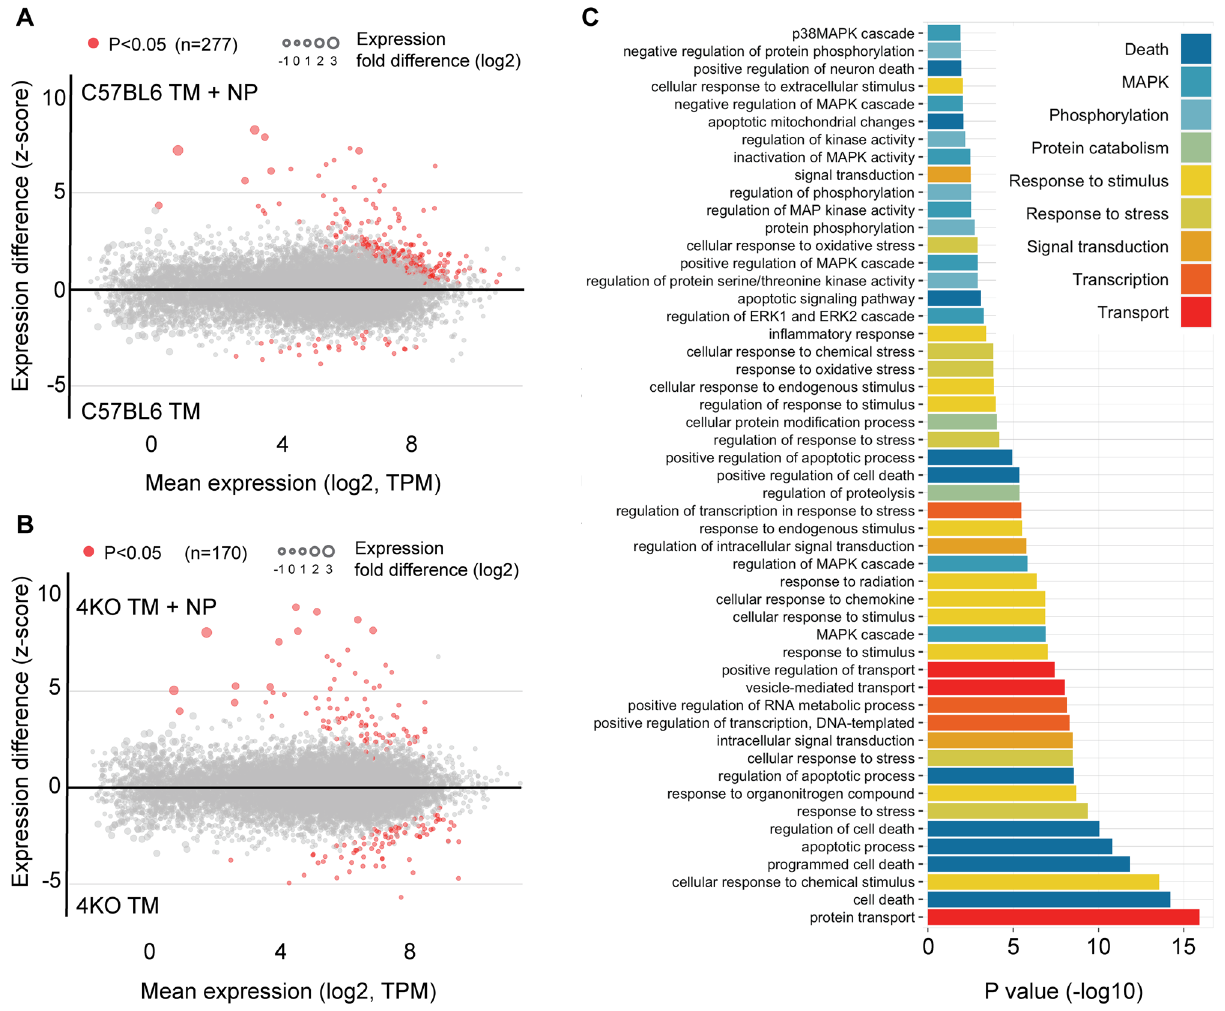
Figure 3. Synthetic nanoparticles trigger activation of MAPK signaling in TM-preconditioned macrophages. (A) Z-score plot of genome-wide differences in expression of genes in macrophages from WT mice treated with TM or TM+NP. Genes differentially-expressed between these two treatment conditions with p < 0.05, based on DESeq2 analysis, are shown in red. (B) Z-score plot of genome-wide differences in expression of genes